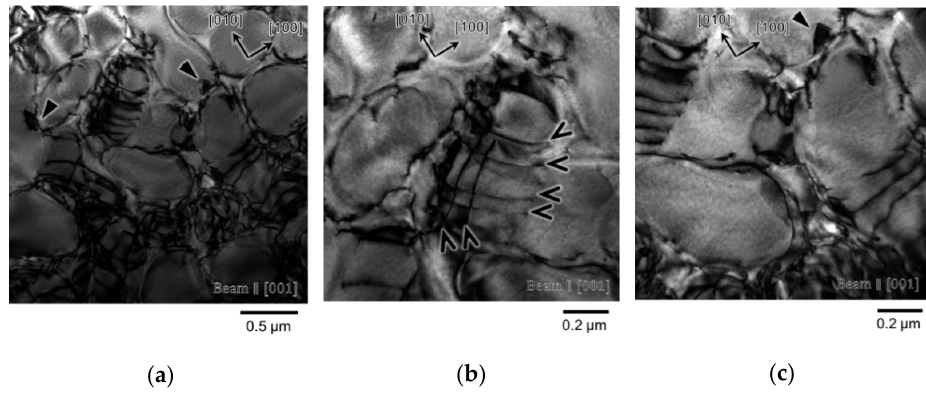
Figure 12. Bright-field images in the 2-h interrupted specimen using TEM from the view of the [001]-zone axis. Black triangle arrows indicate stacking faults in γ′ precipitates. V-shaped arrows indicate <110>-directed dislocations on the γ / γ′ interface.